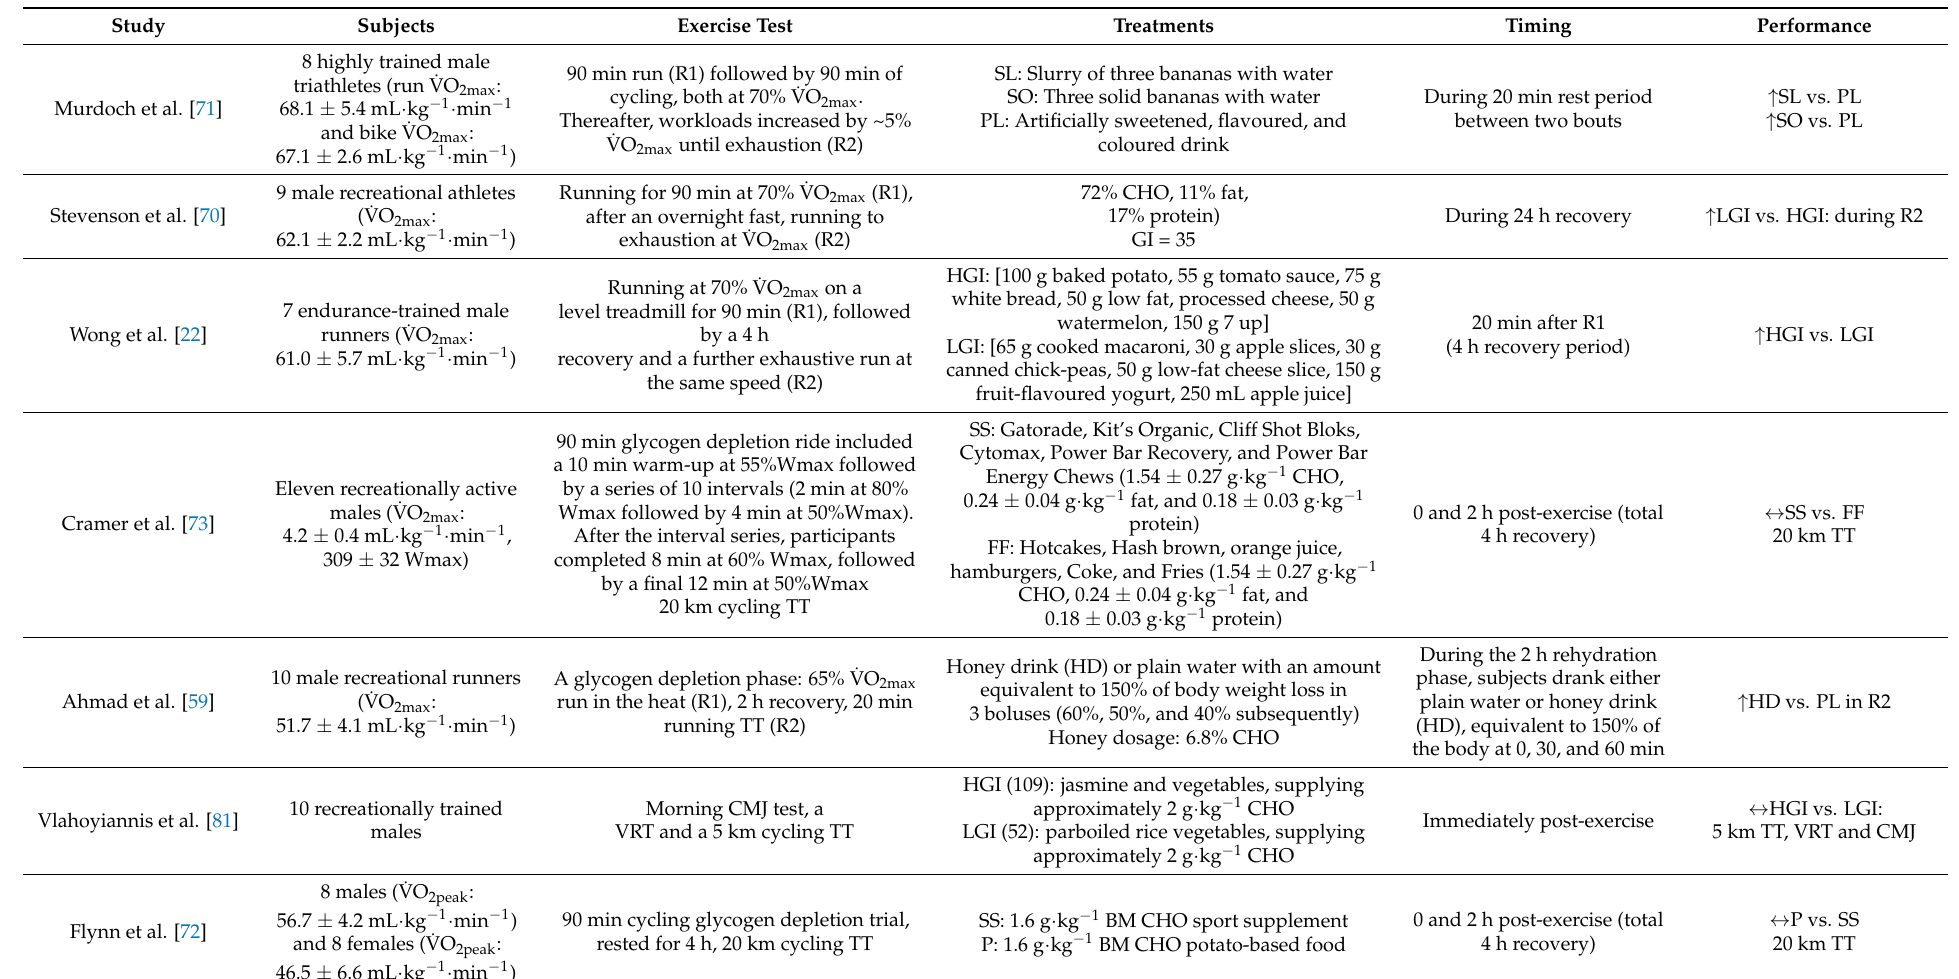
Table 3. Summary of studies exploring the effects of post-exercise CHO food ingestion on